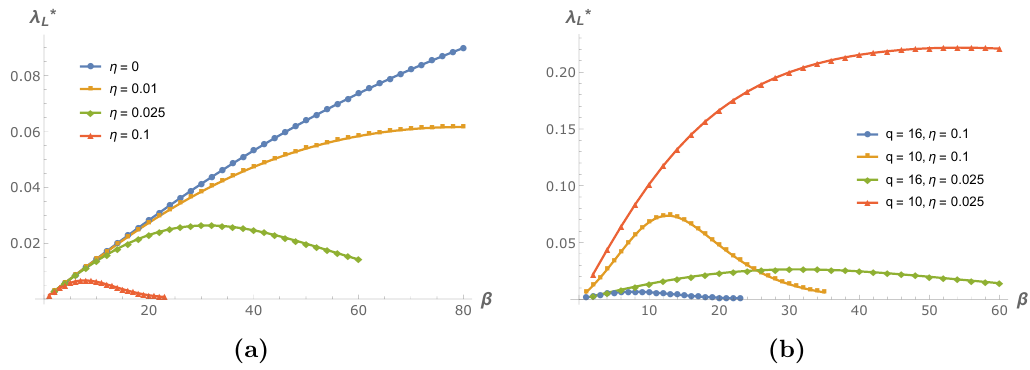
Figure 9. (a) The normalized Lyapunov exponent of q = 16 SYK model for di(cid:11)erent (cid:12)xed (cid:17) as a function of the inverse temperature (cid:12) . (b) The normalized Lyapunov exponent of q = 16 SYK model and q = 10 SYK model for di(cid:11)erent (cid:12)xed (cid:17) as a function of the inverse temperature (cid:12)